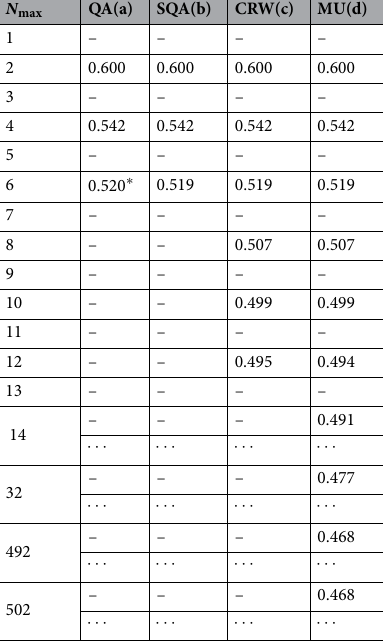
Table 3. The convergence of the correlation factors evaluated by ‘(a) Quantum Annealing with D-wave (QA)’, ‘(b) Simulated Quantum Annealing (SQA)’, ‘(c) Classical Random Walk (CRW)’, and ‘(d) Matrix Updating method (MU)’, depending on the system size N . ( ∗ : The difference from the other methods is attributed to that our QA calculation could count over only 94.54% of the trajectories, because of the limited number of samples due to the computational